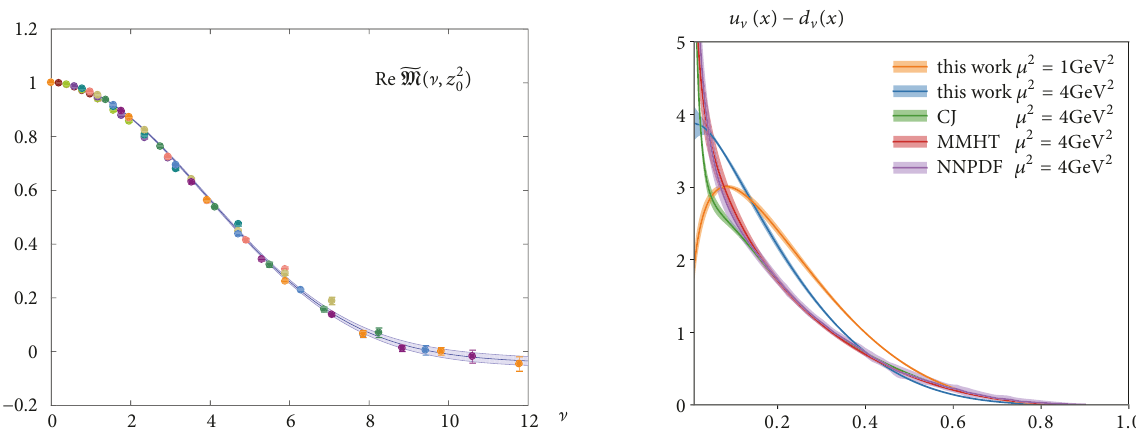
Figure 35: Left: real part of reduced matrix elements with all points evolved to 𝑧 = 2𝑎 ≈ 1 GeV −1 . The points with 6𝑎 < 𝑧 ≤ 10𝑎 were evolved as if they corresponded to 𝑧 = 6𝑎 . The blue band is a fit explained in the text. Right: final PDF resulting from the rescaled data in the left plot and comparison with CJ15 [214], MMHT [212], and NNPDF [211] phenomenological data. Source: [87], reprinted with permission by the Authors and the American Physical Society.